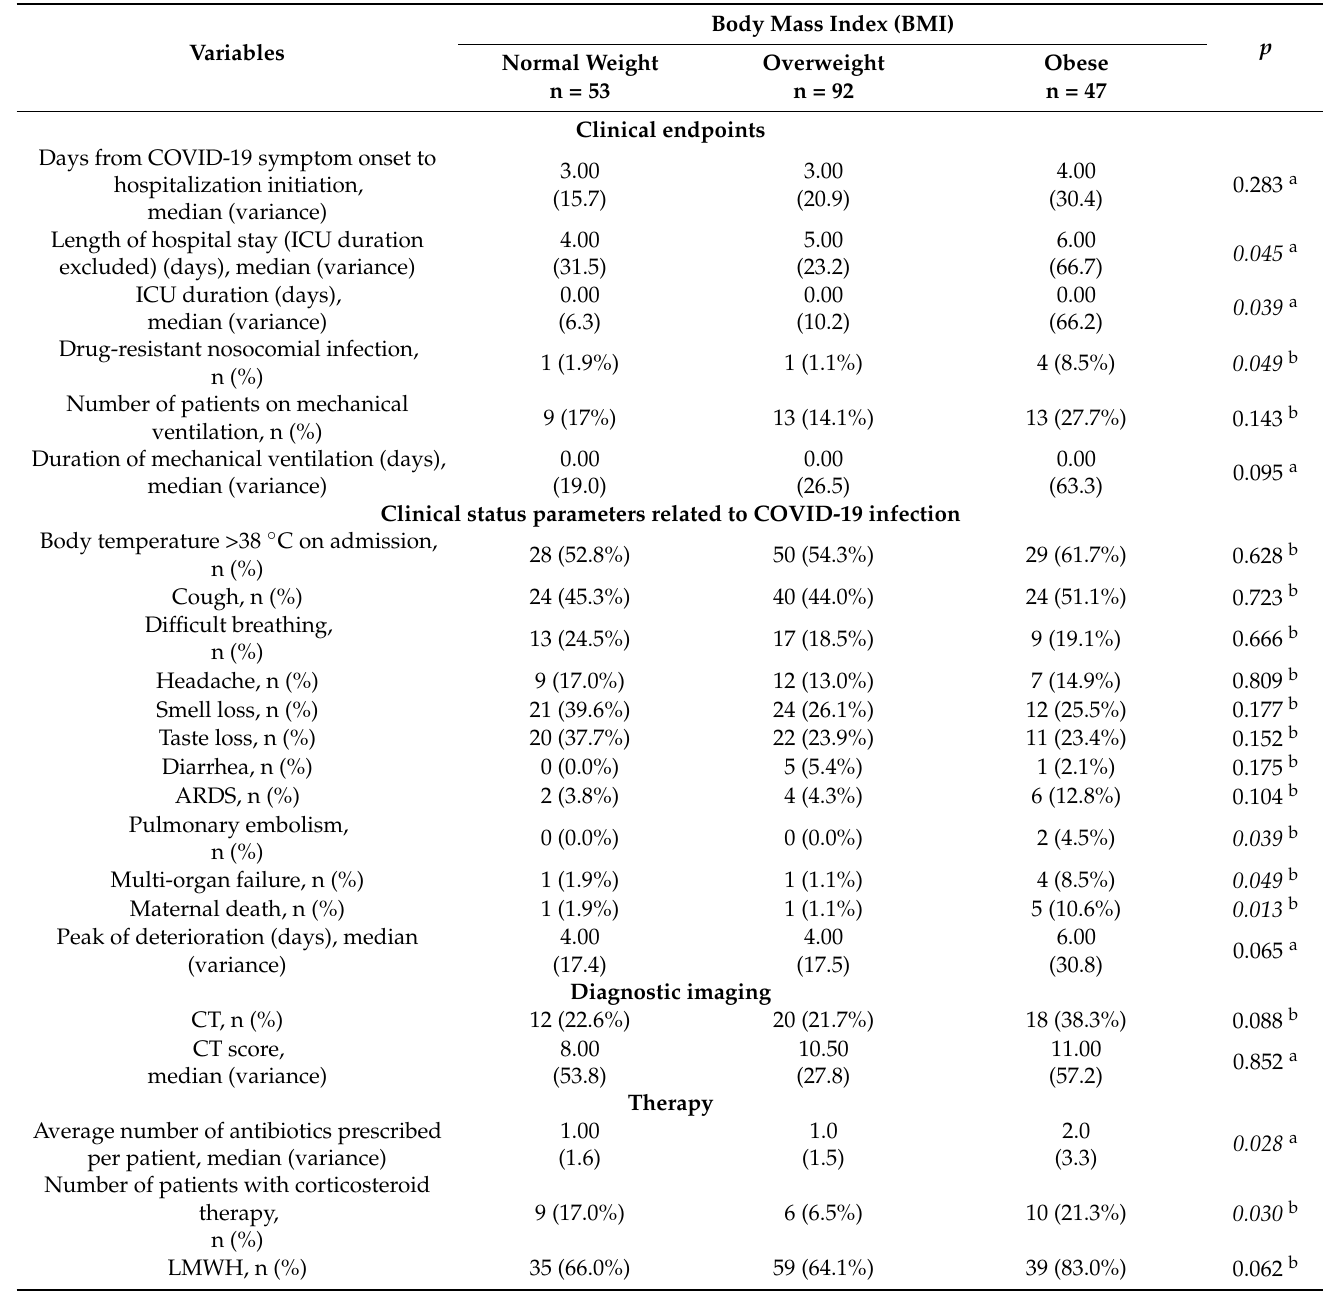
Table 2. Differences in signs and symptoms of COVID-19 in pregnant patients according to their body mass